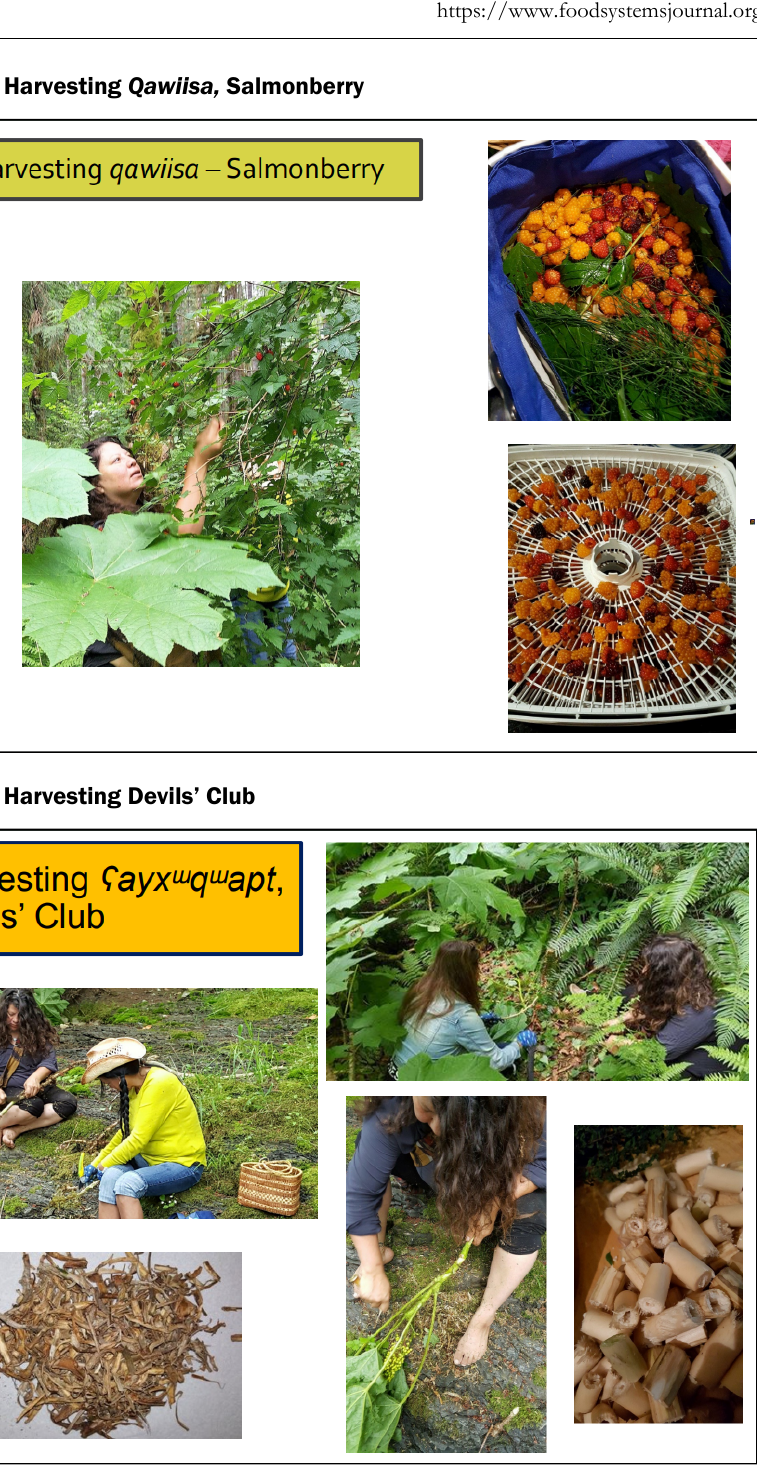
Figure 7. Harvesting Qawiisa, Salmonberry